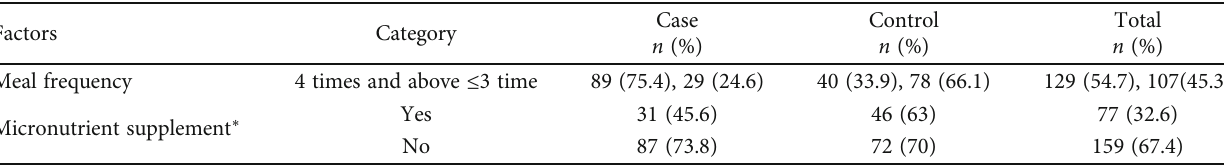
Table 5: Nutritional related factors of study participants during the intensive phase in Debre Markos town public health facilities, Northwest Ethiopia,